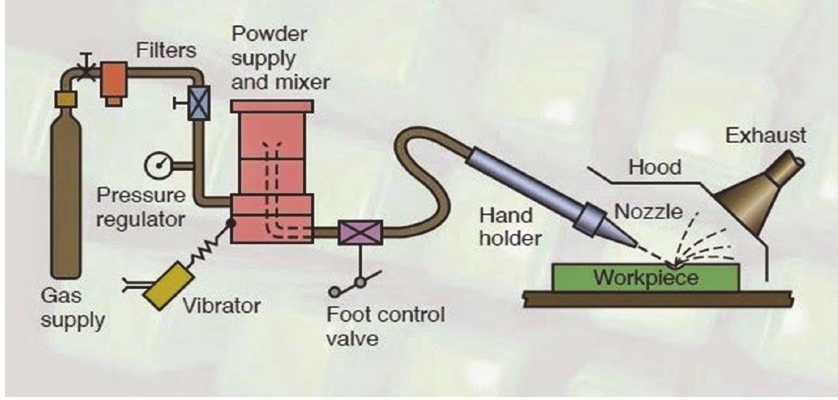
Fig. 1. A simple schematic diagram of Abrasive Jet Machining